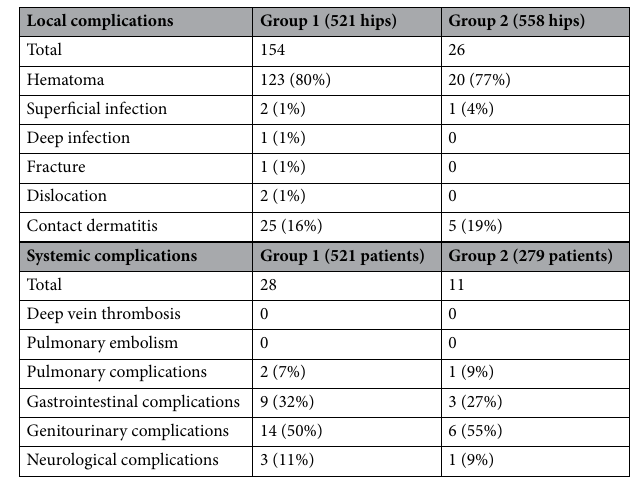
Table 1. Number of local and systemic complications in the two